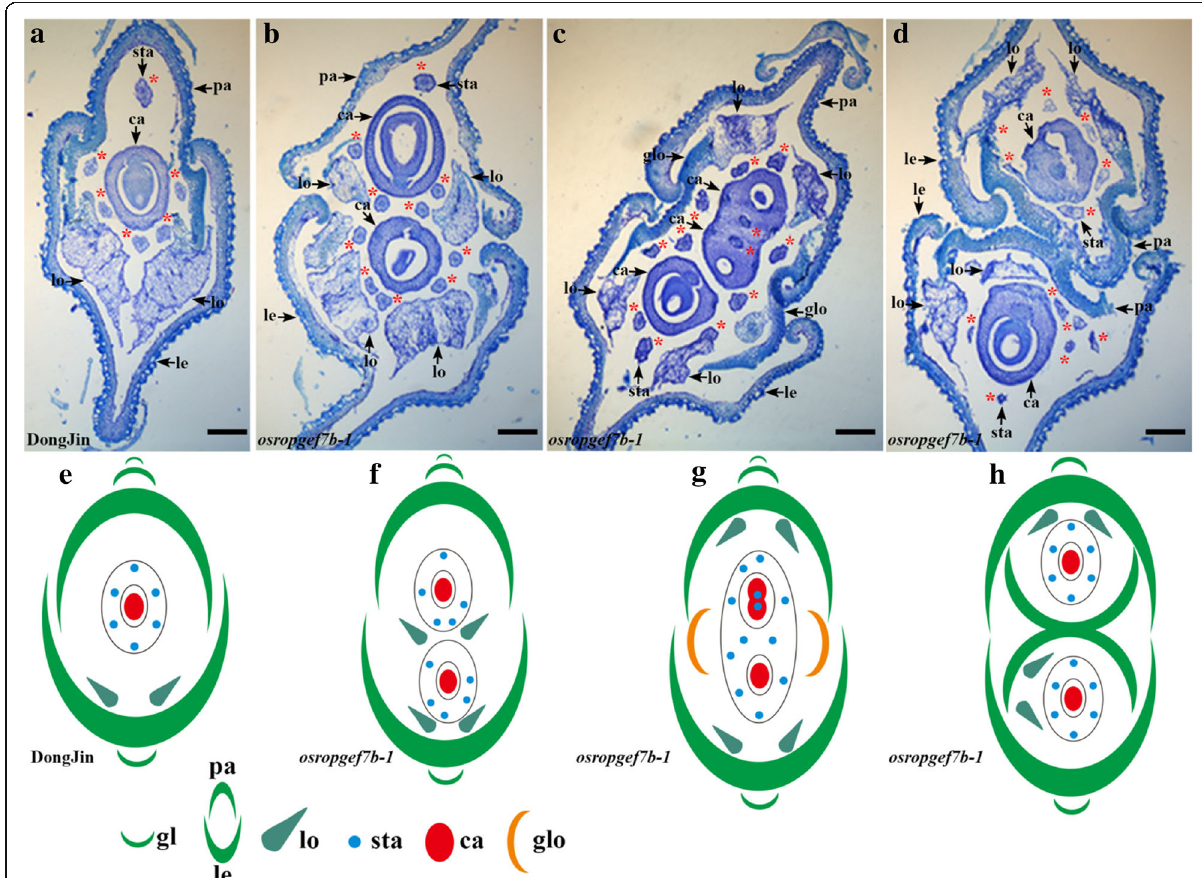
Fig. 3 Microscopic analyses of paraffin sections of wild type and osropgef7b-1 spikelets at basal position. a Transverse section of wild type. Stamens were marked with asterisks. b - d Transverse section of osropgef7b-1 . b A flower with two carpels in different sizes, ten stamens and four lodicules, and non-overlapping lemma and palea. c A flower with three carpels, two of which were fused together, twelve stamens, two glume- like organs, four lodicules, and non-overlapping lemma and palea. d A flower with twelve stamens, four lodicules, and two carpels separated by two partially fused paleae. e - h ) Sketches depicting the upper photos of paraffin sections, ( e ) for ( a ), ( f ) for ( b ), ( g) for ( c ), and H for D, respectively. e wild type and ( f - h ) osropgef7b-1 flowers. ca, carpel; gl, glume; glo, glume-like organ; le, lemma; lo, lodicules; ov, ovary; pa, palea; sta, stamen; Scale bars: ( a to d ) 100 μ